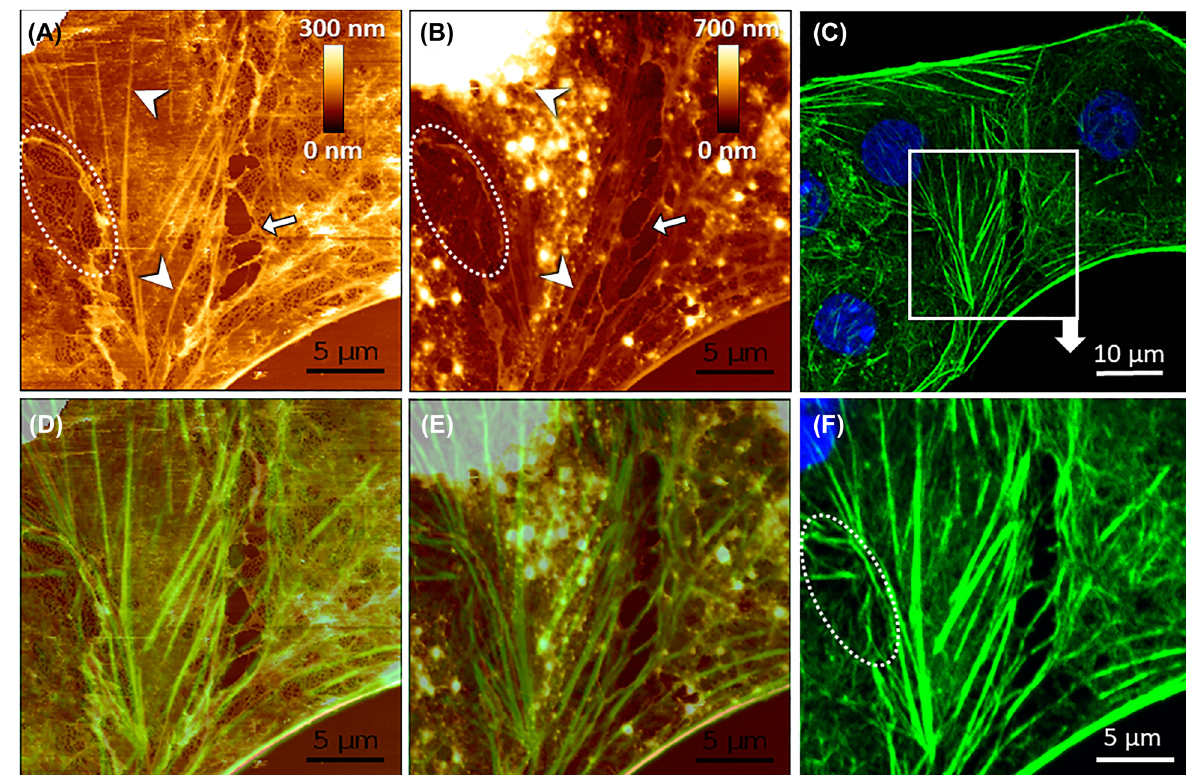
Figure 6: Correlative AFM and conventional fluorescence microscopy of LSEC. (A) The topography of live cells was measured using AFM. (B) The same area measured after fixation with 1% GA. (C) LSEC were then labeled with phalloidin-Atto488 (green) for actin and Hoechst 33258 (blue) for cell nuclei, and the same area was localized using landmarks. (F) The areaofinterestcorrespondingtoAFMmeasurementswasselected.(DandE)presentmergedAFMandfluorescencemicroscopyimagesmade, respectively,forliveandfixedLSEC.Comparativedataallowidentifyingactinstressfibersinlivecells(whitearrowheads),whichvisualization ishinderedinfixedcells.FenestrationscanbeidentifiedasdarkspotsinAFMimagesofbothlive(A) and fi xed(B)LSEC(dotted-linecircle)but not in fl uorescence microscopy images (F). Different sizes and position of gaps in live and fi xed cells corresponds to cell migration prior to fi xation (white